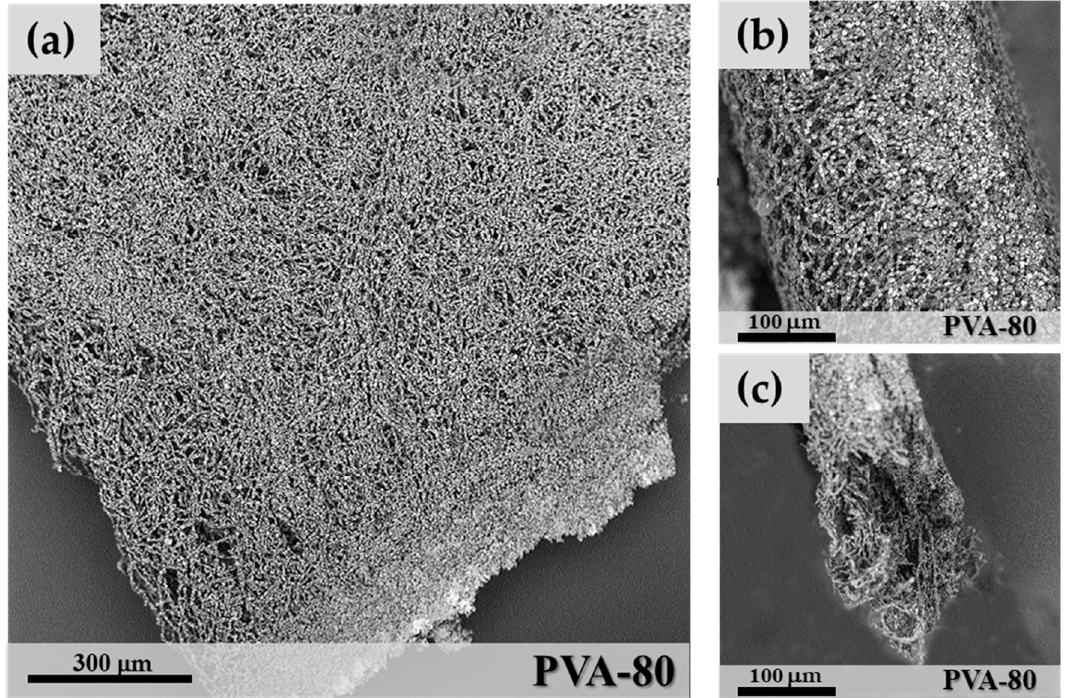
Figure 1. SEM image of a microfibre coating of sample PVA-80 ( a ); Coating cross-section ( b ) and a fracture surface ( c ).